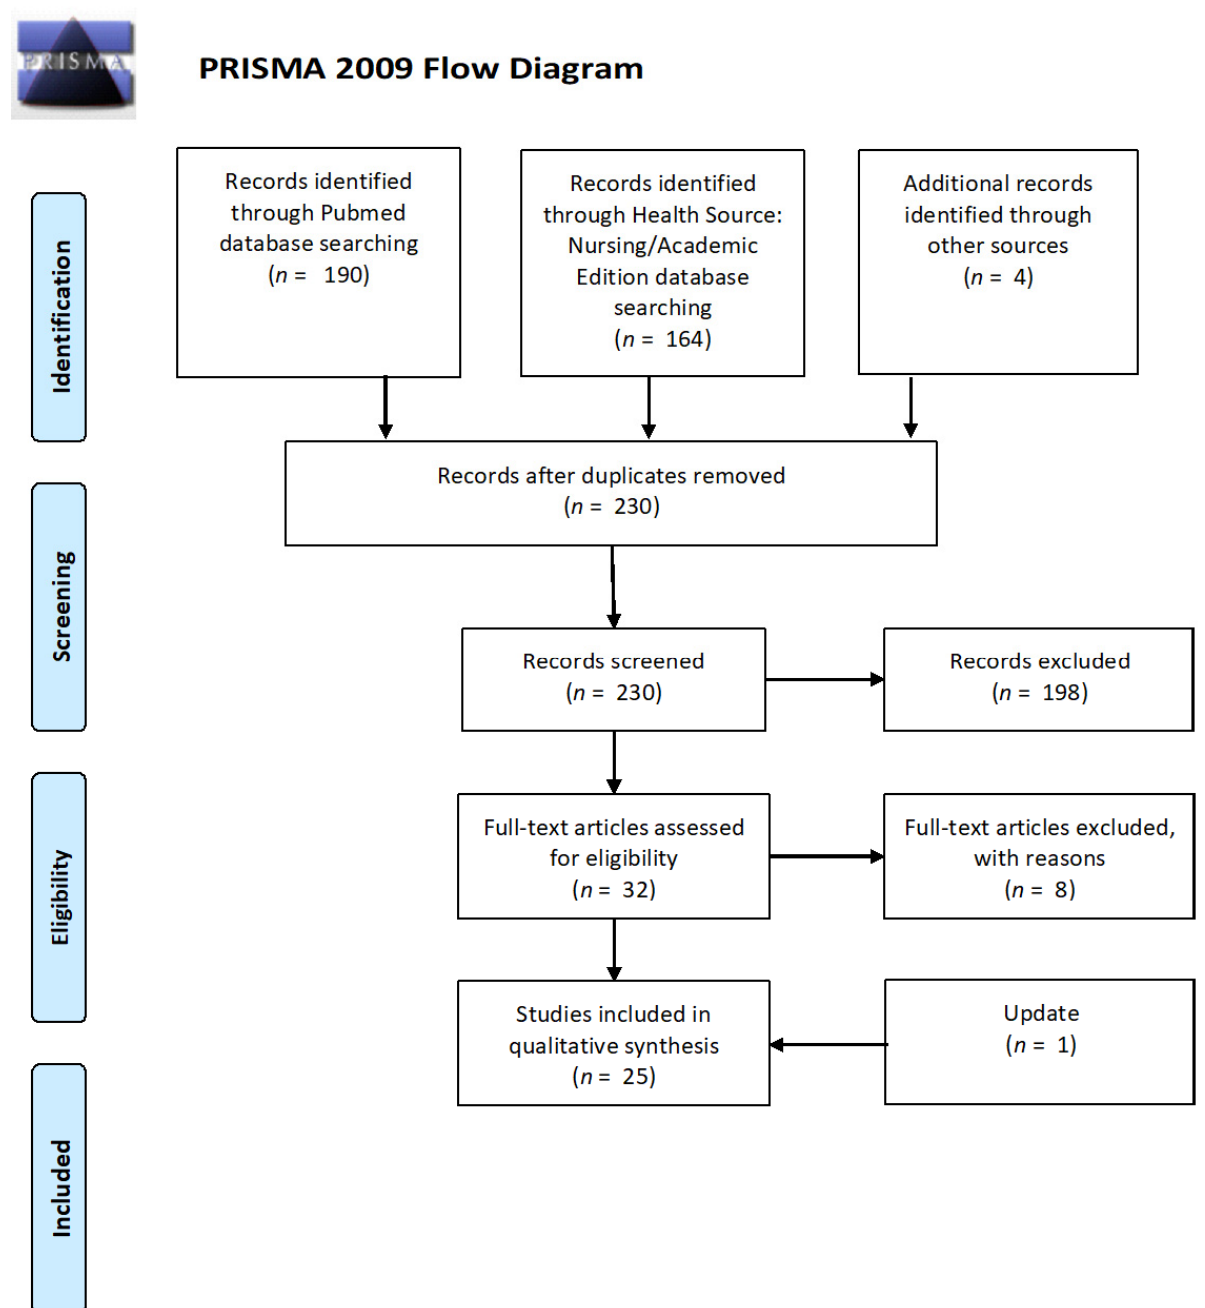
Figure 1. PRISMA flow diagram [29].